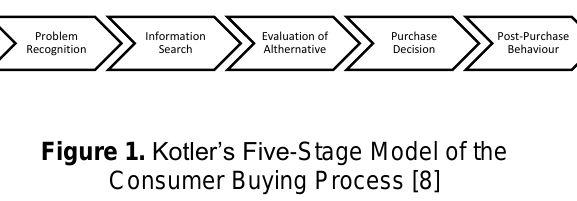
Figure 1. Kotler’s Five -Stage Model of the